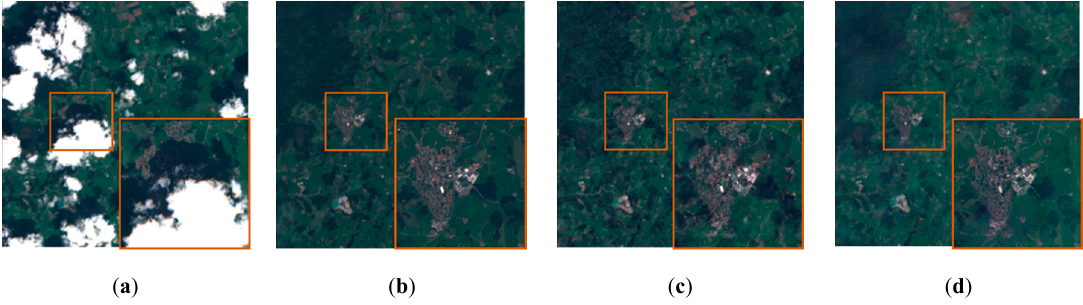
Figure 9. Results of Area 3 in the real experiment. ( a ) Ground truth of the optical image. ( b ) Pix2pix.